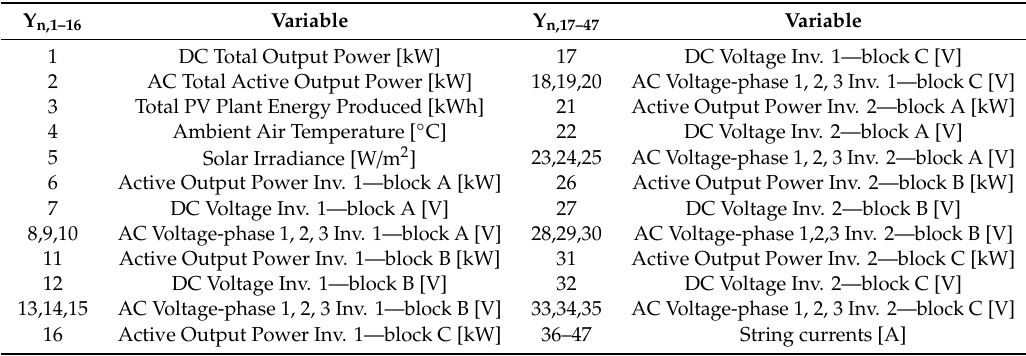
Table 1. Monitored PV plant